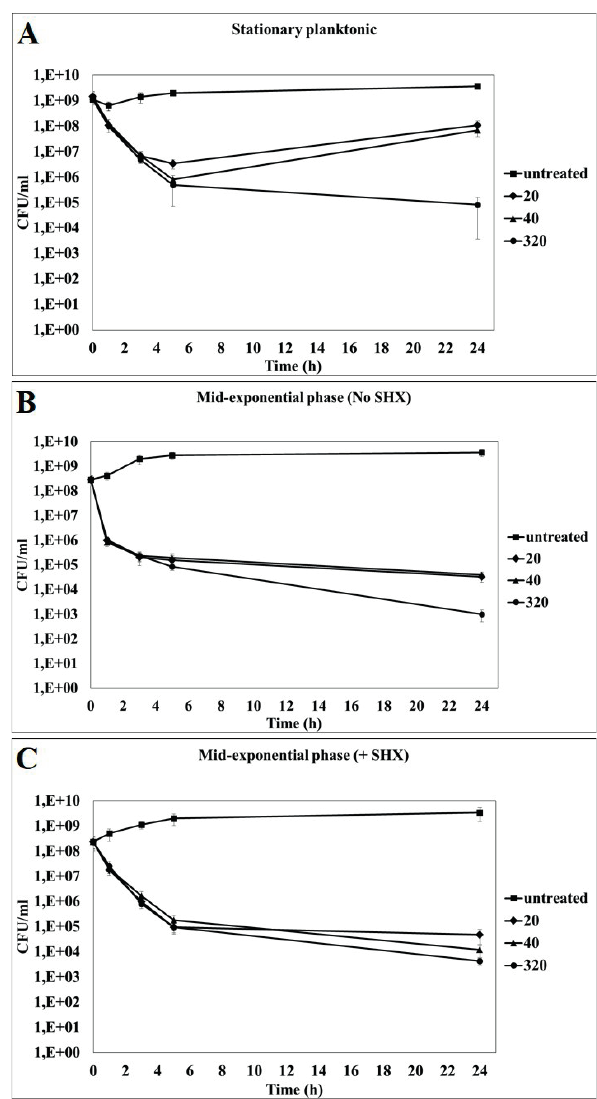
Fig. 1. Killing of P. aeruginosa PAO1 wild-type cells by imipe- nem. Cells of stationary-phase (A), exponential-phase untreated with SHX (B) and exponential-phase cultures treated with SHX (C) were exposed to 20-, 40- and 320-μg/mL of imipenem (MIC is 4 μg/mL) for 1, 3, 5 and 24 h and then plated for colony forming units (CFU/mL). The percent survival is not shown. The values are averages of three independent experimetns, and the error bars indicate the standard error of the